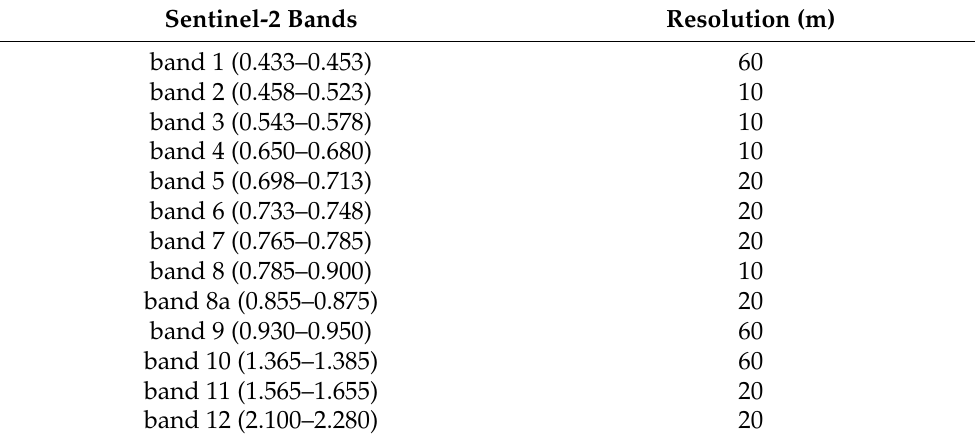
Table 1. Sentinel-2 spectral bands and spatial